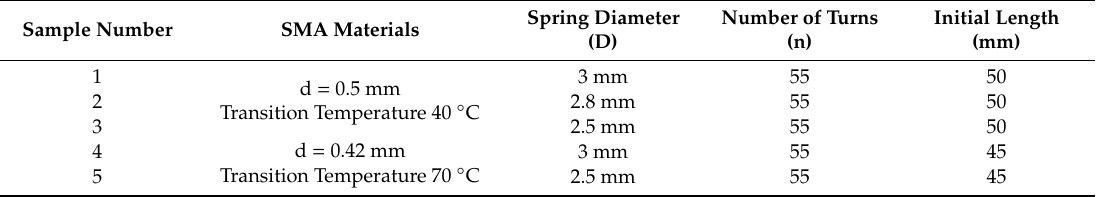
Table 1. Parameters of five shape memory alloy (SMA) coil spring samples.